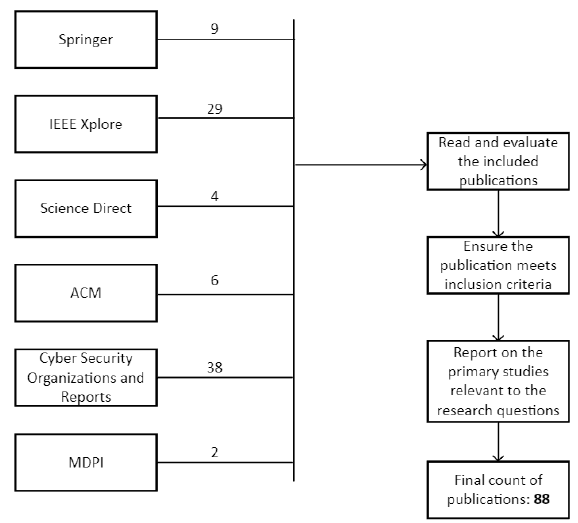
Figure 2. Publication selection and inclusion.